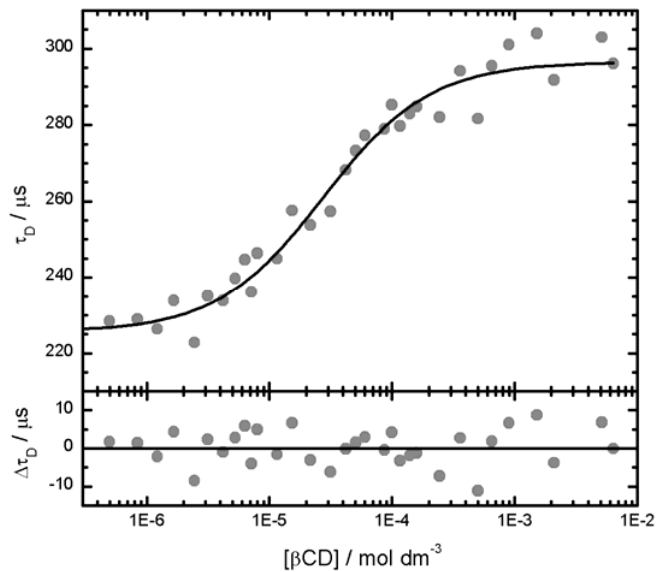
Figure 5. Upper panel: Mean diffusion times τ as function of β CD concentration D determined from individual fits of correlation function G [Equation (9)] to the DT normalized correlation curves of Figure 4. Parameter of the fit as given in the text. The black curve represents the best fit of Equation (10) to τ with the parameter D τ = 225 ± 2 μ s, τ = 297 ± 2 μ s, and K = (48 ± 7) × 10 3 mol -1 dm 3 . Note that due to the f b logarithmic concentration scale the values at [ β CD] = 0 M are not visible in the figure, although they are included in the fit. Lower panel: residuals of the